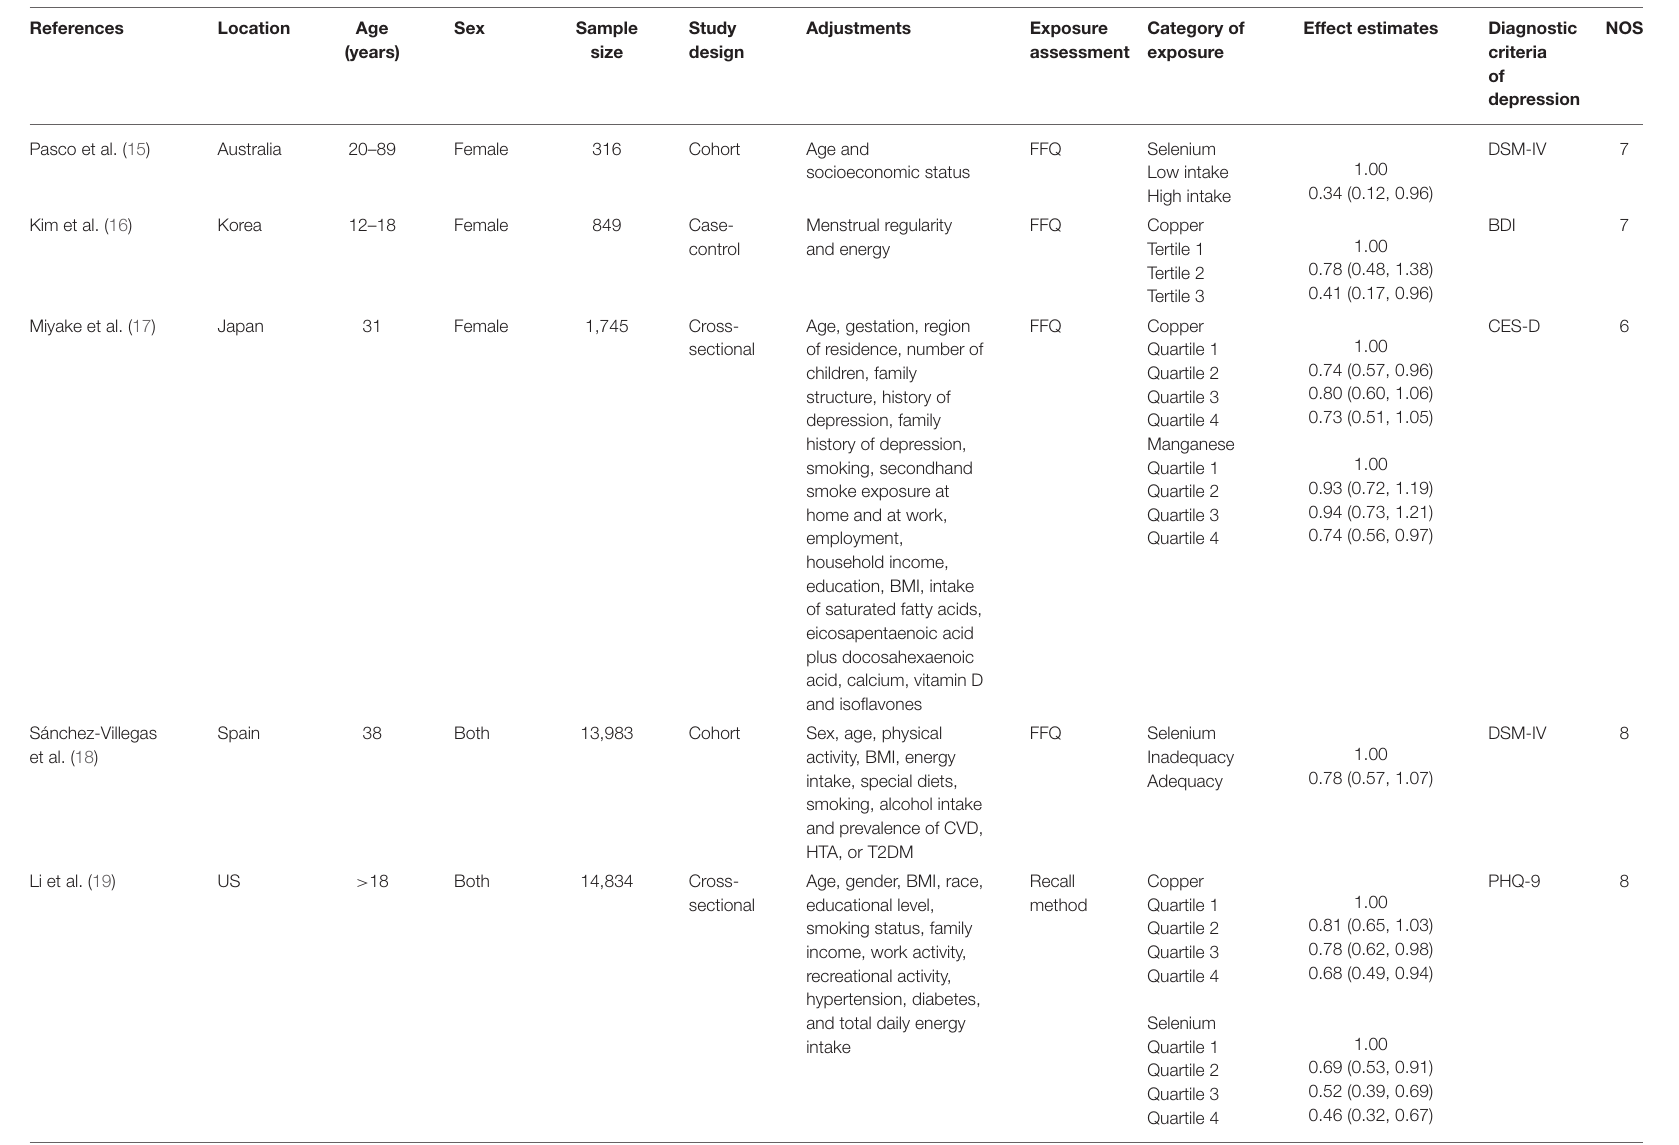
TABLE 1 | Characteristics of the individual studies included in this